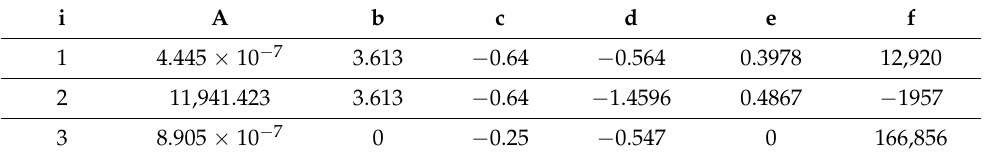
Table 3. a i to f i F model